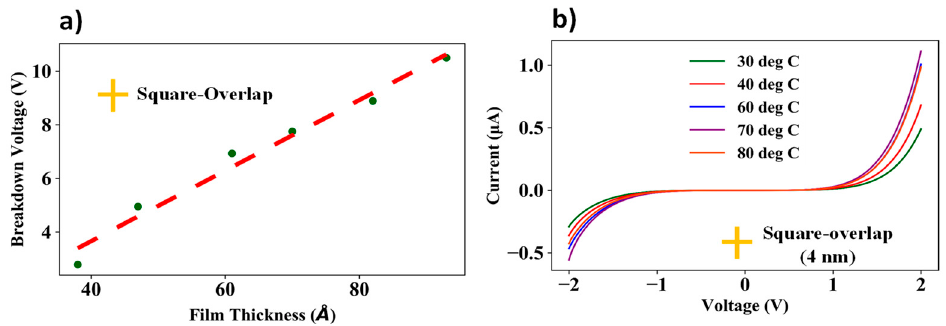
Figure 13. ( a ) Experimentally determined breakdown voltage vs. spacer film thickness (4–9 nm) for square ‐ overlap layout and ( b ) I–V characteristics of 4 nm spacer thickness square ‐ overlap layout for di ff erent different temperatures.